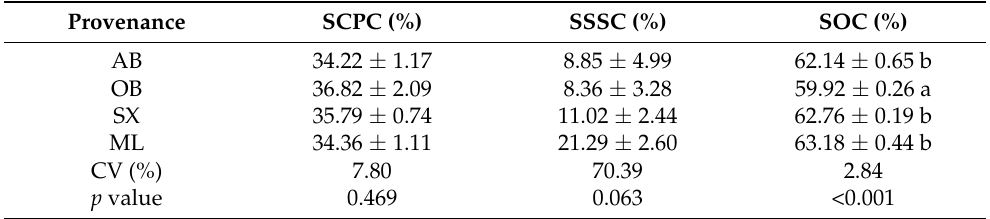
Table 4. Variation in concentrations (%) of seed crude protein, soluble sugar, and oil among four X. sorbifolium provenances.